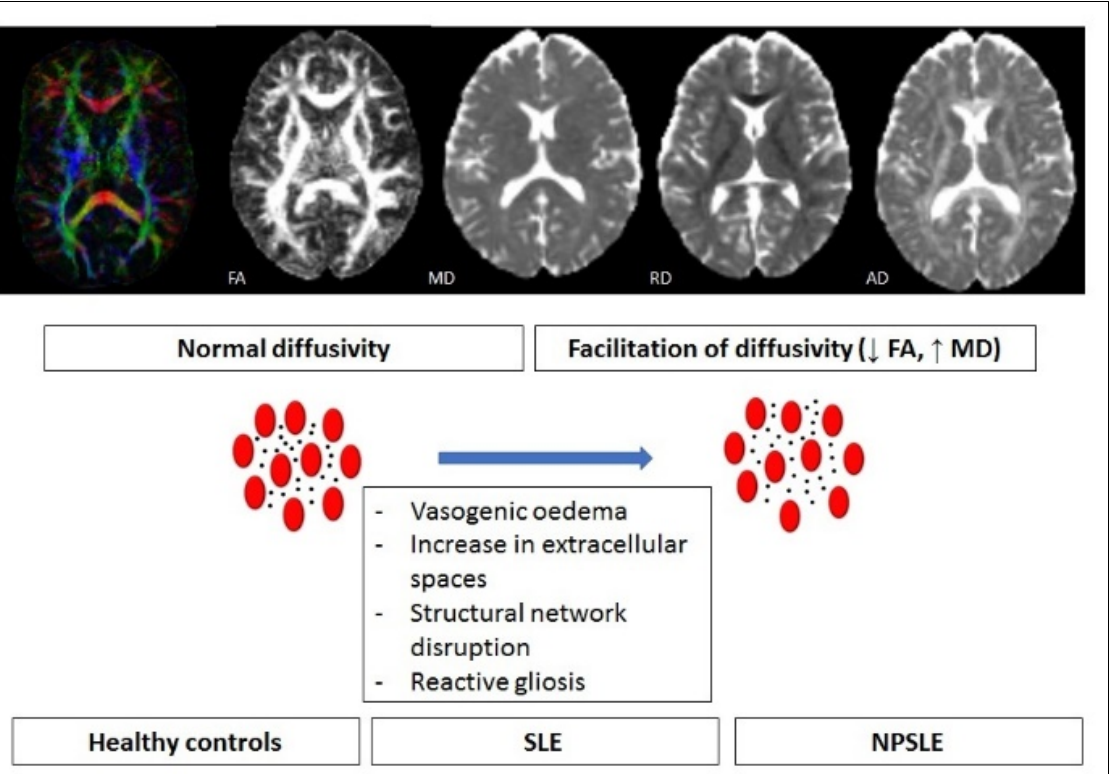
Figure 2. Pictorial summary of main DTI studies in the context of SLE and NPSLE. The reduction in FA and the increase in MD values in several WM tracts suggest global facilitation of cerebral diffusivity, occurring both in SLE and NPSLE. These aspects suggest different pathogenic events, such as vasogenic oedema, increase in extracellular spaces, structural network disruption, reactive gliosis.